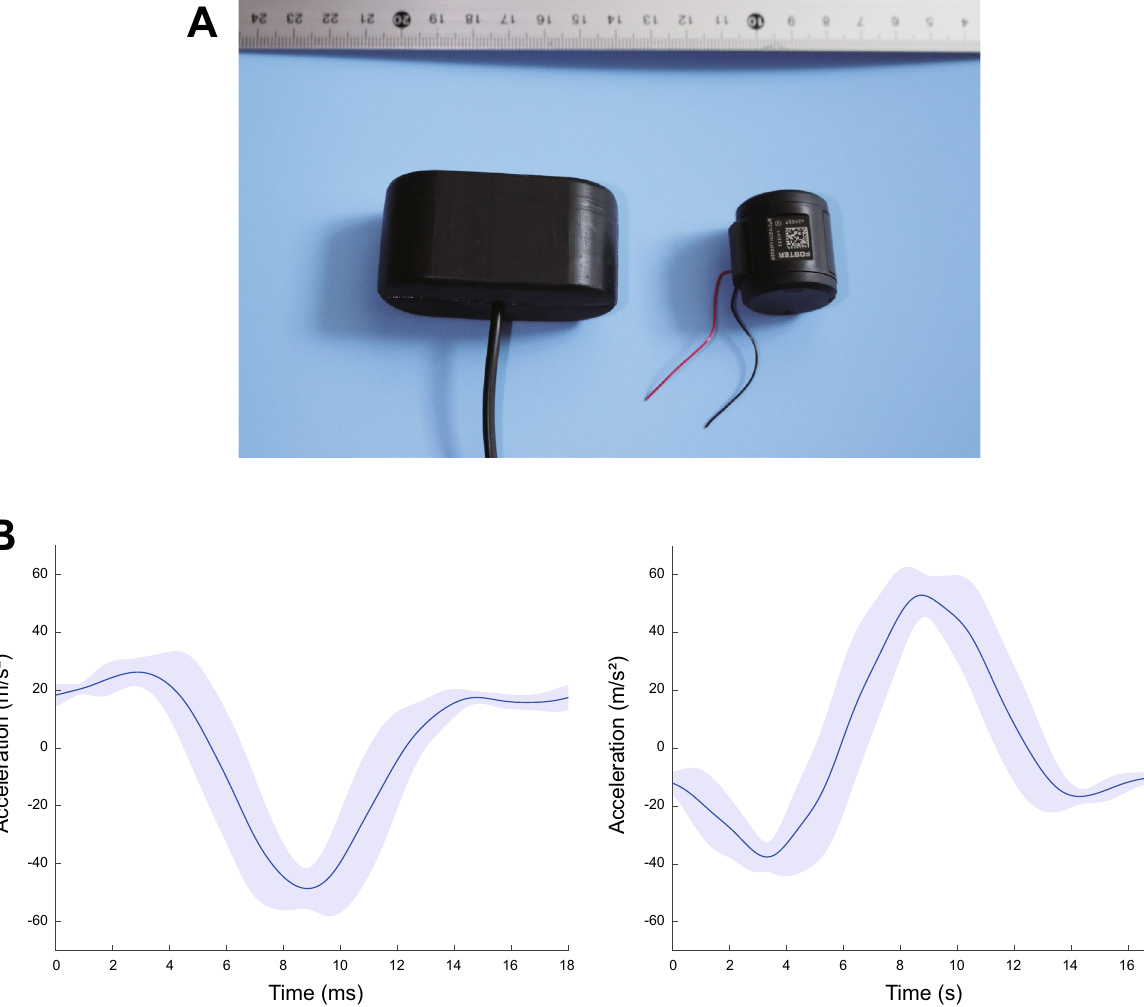
Figure 3. ( A ) Haptic device used in the experiment (left) and voice-coil actuator inside it (right). ( B ) Variation of the vibrator acceleration over one cycle producing either a forward (left) or backward (right) force sensation.